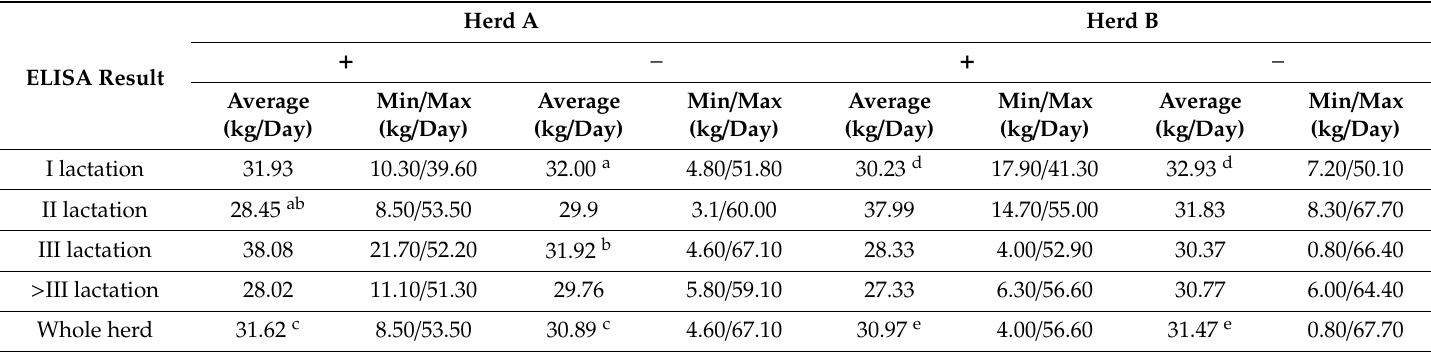
Table 2. A comparison of the results of the milk yields (kg / day) of seropositive and seronegative cows in two tested herds (A and B).